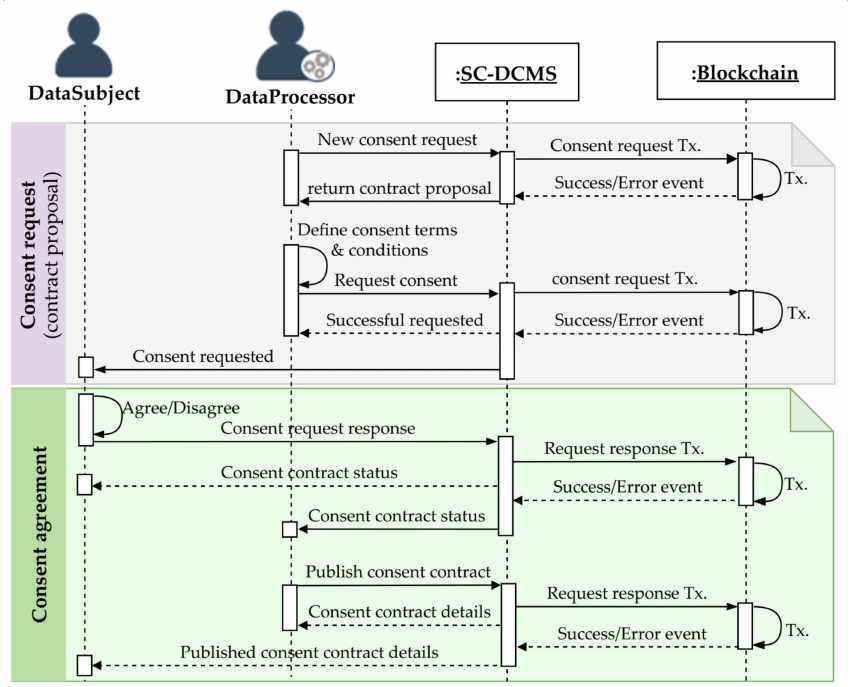
Figure 4. Consent request and agreement between participating entities of the SC-DCMS.